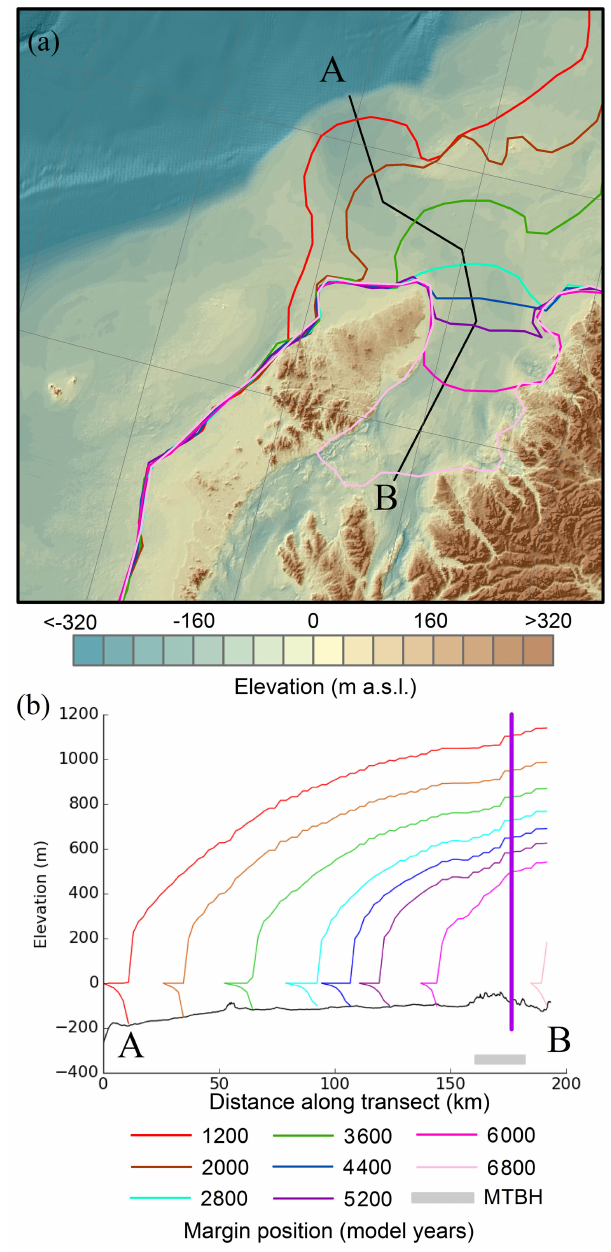
Figure 6. (a) The grounding line position of the ice sheet at 800-year intervals during the RETREAT simulation. (b) Transect through the ice stream showing the ice sheet elevation at the same intervals. The purple line marks the grounding line position in the stable “collapsed” ice sheet state from the READVANCE simula- tions (Fig. 7d).